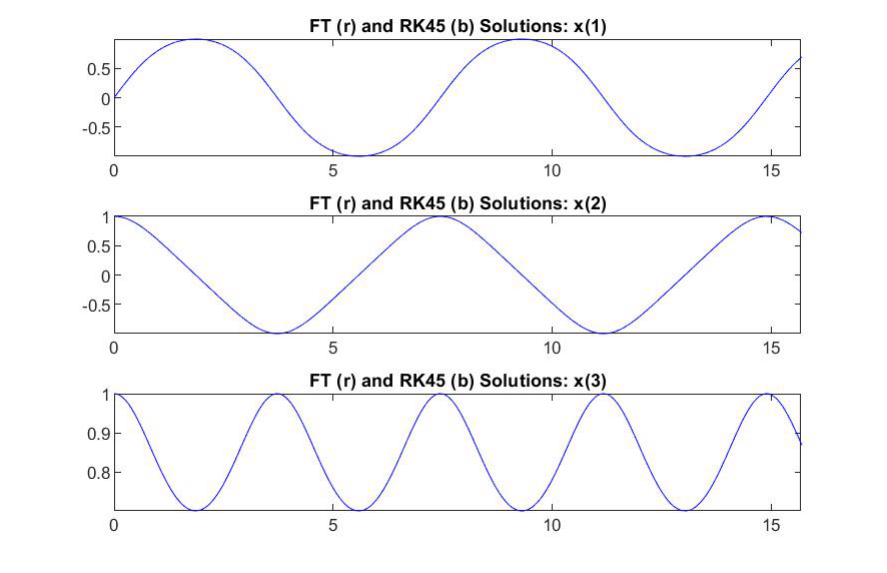
Figure 1. Problem No1: The three components x j ( t ) , j = 1,2,3 are displayed in the order from top to bottom; FT solution is red-colored, RK solution is blue-colored. The two solutions are highly coincident at all points.